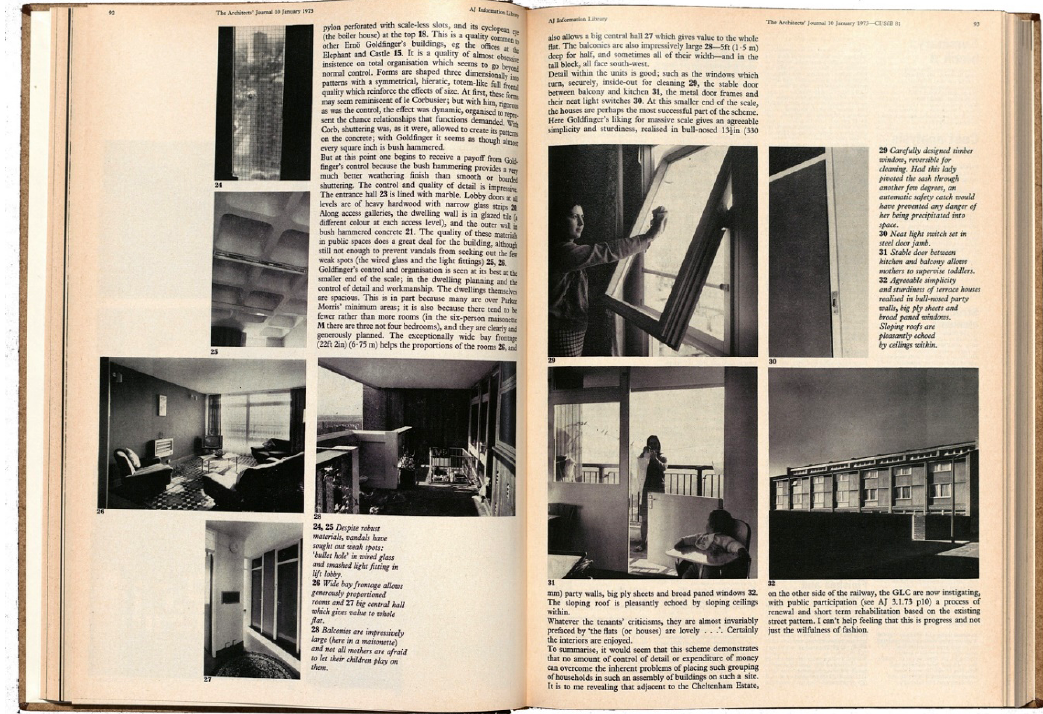
Figure 15. Richardson M. (1973). Cheltenham Estate housing, Architects’ Journal , 157 . to equal, with its three residential towers and the dense neighbourhood